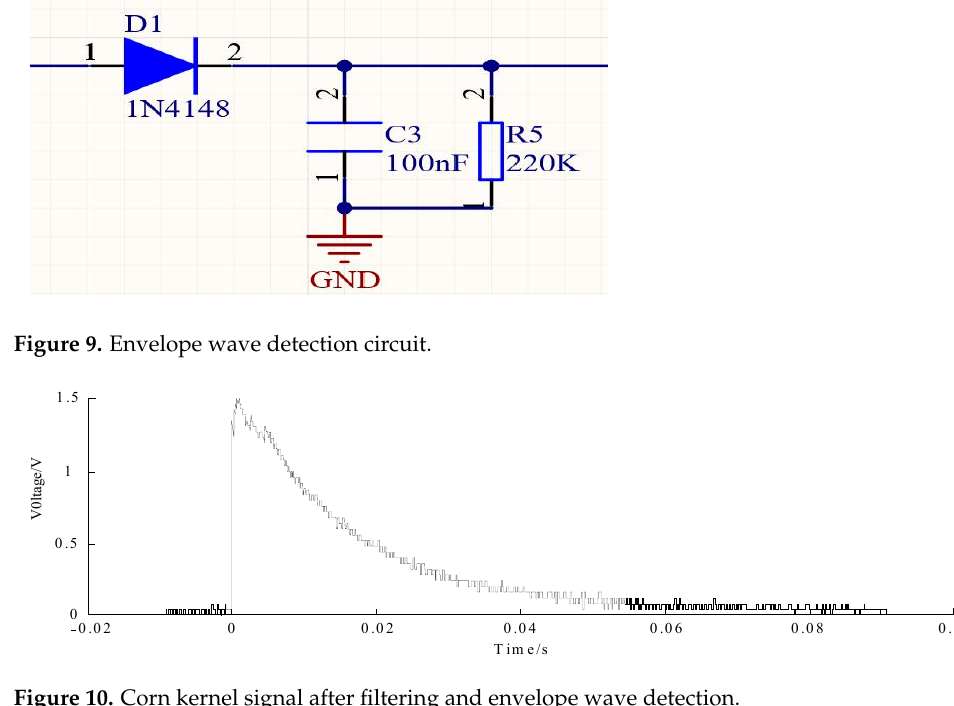
Figure 10. Corn kernel signal after filtering and envelope wave detection.